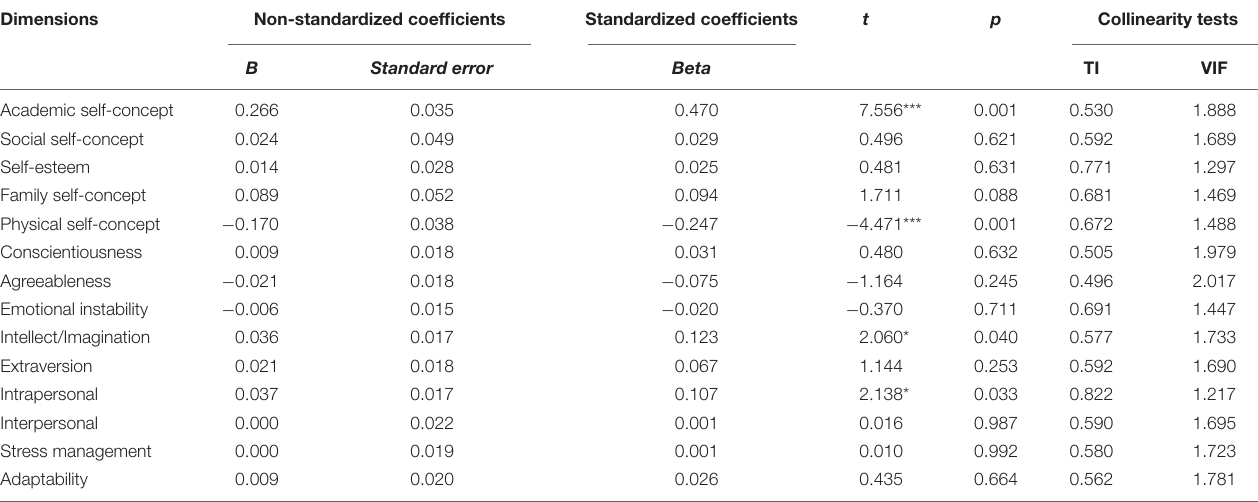
TABLE 5 | Regression analysis of the different dimensions analyzed with respect to the Spanish language and literature subject.